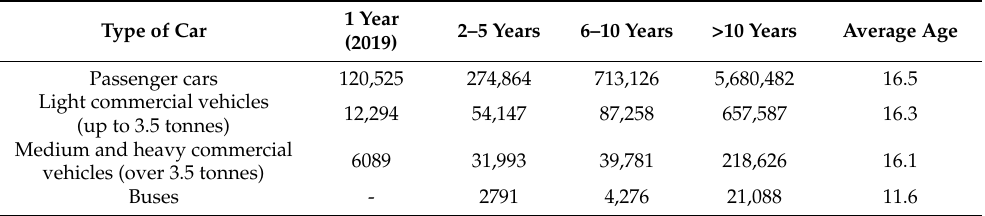
Table 5. Vehicles in use by age in Romania. Table made by authors with data source from ACEA [52] (data use with copyright